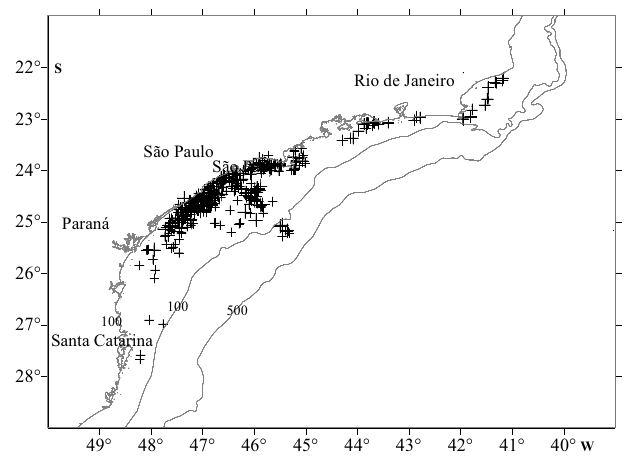
Fig. 1 . Map of the study area, southeast Brazil, south-western Atlantic Ocean. Symbols represent all the fishing hauls from where samples of Rioraja agassizi were